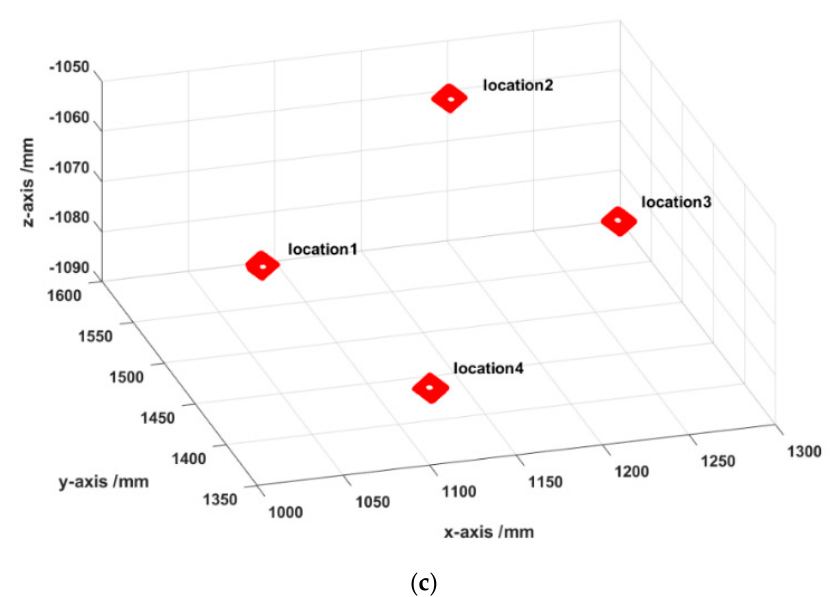
Figure 10. ( a ) Experimental setup for measuring the key local features. ( b ) Surface point clouds from four measurements. ( c ) Reconstructed point clouds of the key local features.